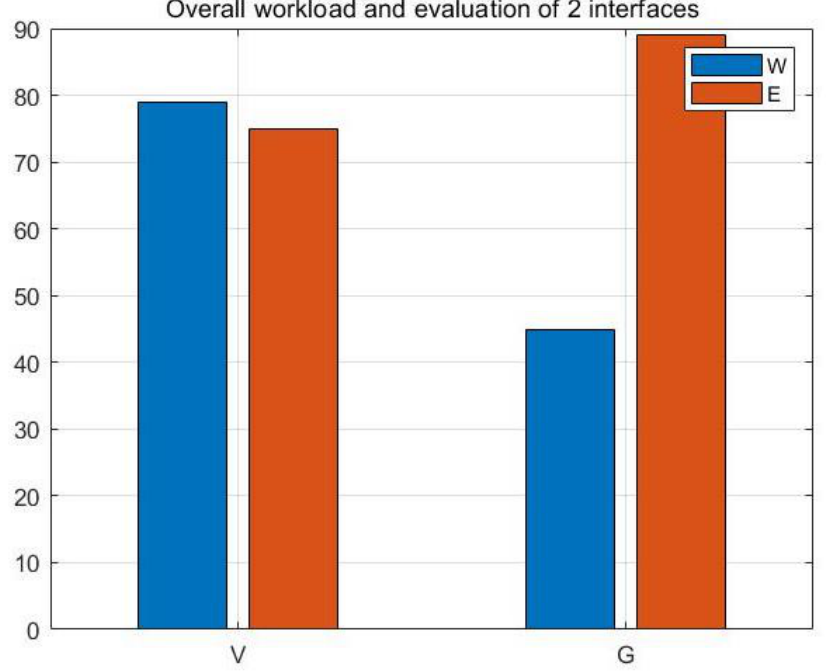
Figure 12. Subjective evaluations. V stands for Visual Interface. G stands for Gesture Interface. W means workload. E means